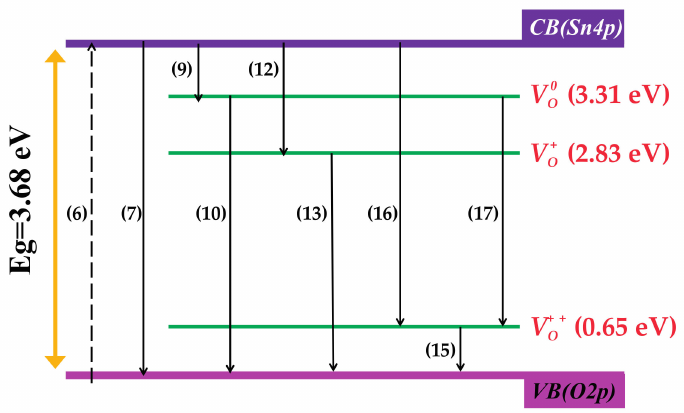
Figure 8. Schematic representation of relaxation process in photoexcited FTO